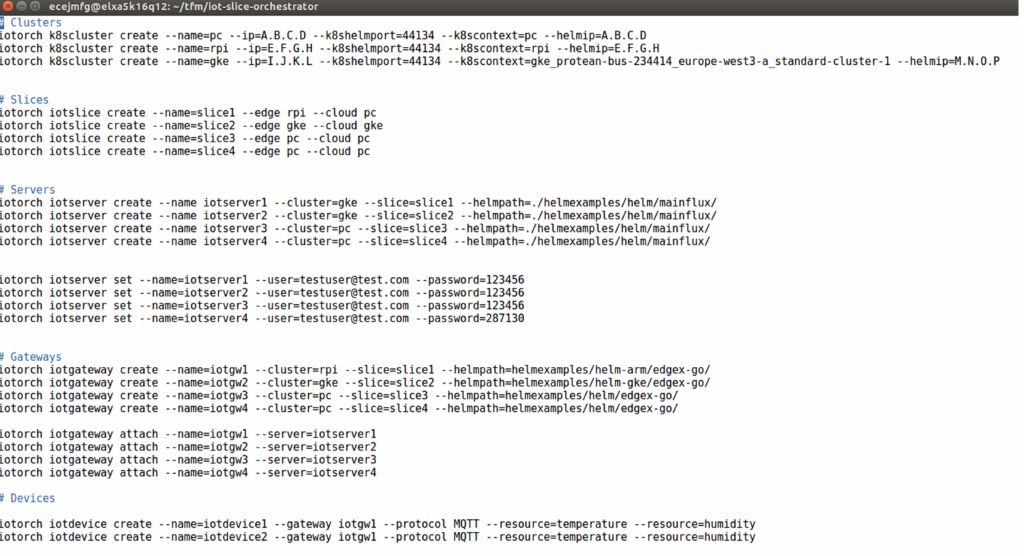
Figure A2. Example of commands used to create slices, servers, gateways and